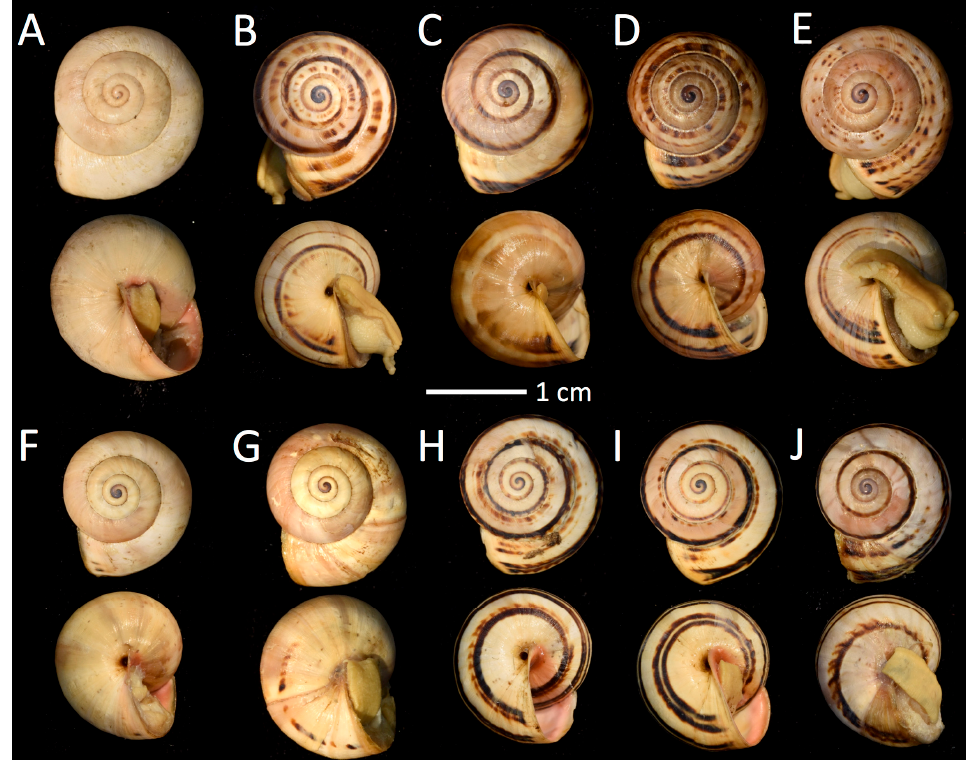
Figure 3. Apical and umbilical view of Theba pisana (Müller, 1774) collected in San Pedro, Los An- geles Co. ( A – E ) and San Elijo Lagoon Ecological Reserve, San Diego Co. ( F – J ), California, USA. ( A ) from outside the Marine Mammal Care Center, LACM 182330; ( B – E ) White Point Nature Preserve, LACM 182331; ( F – J ) from Santa Carina trail at San Elijo, LACM 182335.